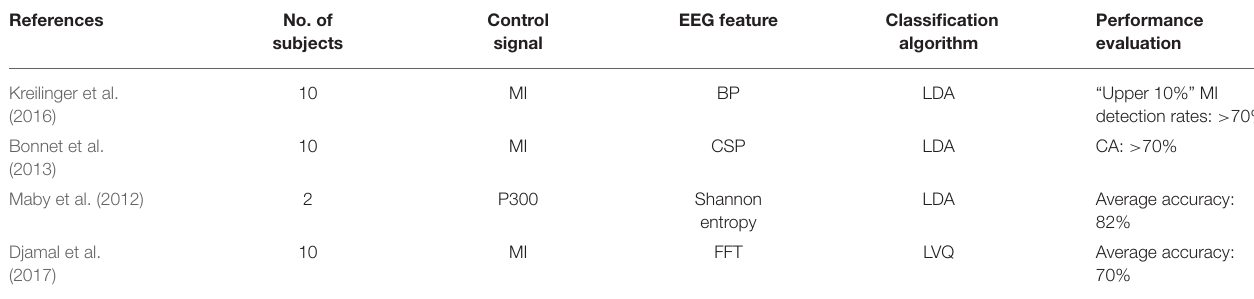
TABLE 8 | Summary of EEG-based BCI gaming and VR